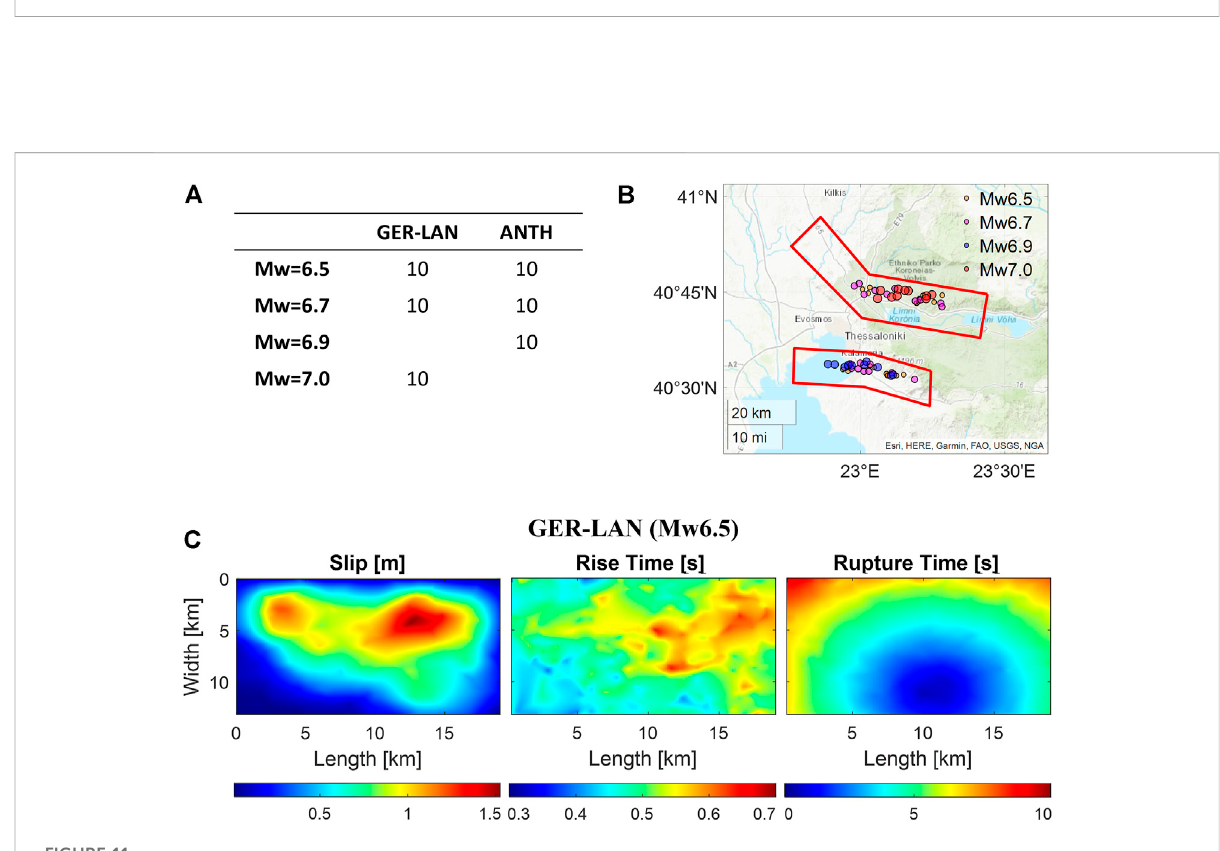
FIGURE 11 (A) List of earthquake scenarios rupturing from the GER-LAN and ANTH faults. (B) Epicenter distribution of the simulated earthquake scenarios. (C) Example of rupture realizations (M W 6.5 on GER-LAN fault) in terms of co-seismic slip, rise time and rupture